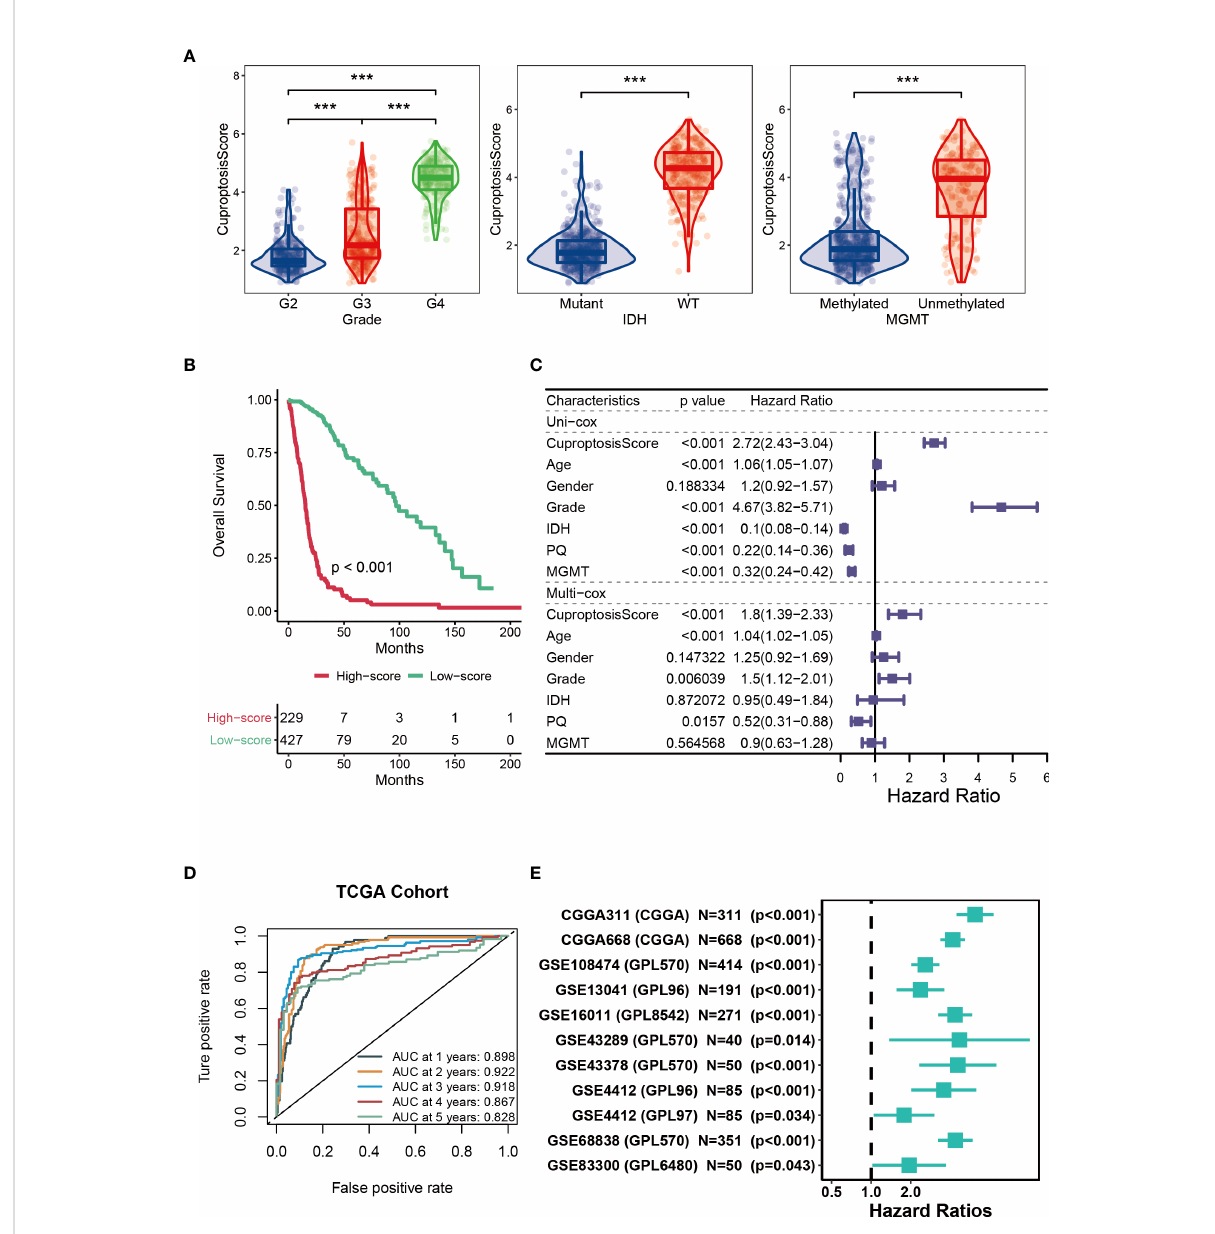
FIGURE 3 Prognostic potential of cuproptosis-signature. (A) The violin fi gures for comparing the CuproptosisScore of TCGA patients among WHO grades, mutation status and MGMT methylation status. (B) Kaplan-Meier survival curve showing survival probability of high-CuproptosisScore or low- CuproptosisScore subgroups. (C) The forest fi gure for Univariate or Multivariate Cox regression analysis of CuproptosisScore and clinicopathologic features. (D) The 1-year, 2-year, 3-year, 4-year, and 5-year survival ROC curves are predicted by the cuproptosis-signature. (E) Univariate Cox regression analysis of the cuproptosis-signature in 11 external validation data sets. ***P <